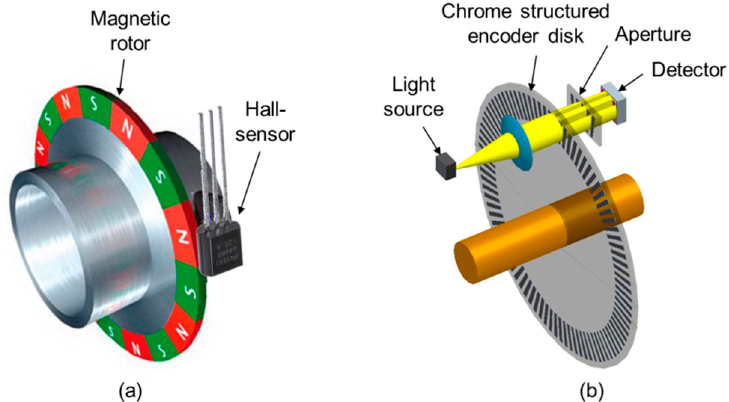
Figure 1. ( a ) Operating principle of a magnetic encoder with a magnetic rotor and hall sensor; ( b ) operating principle of an optical encoder with a light source, encoder disc, aperture, and detector.